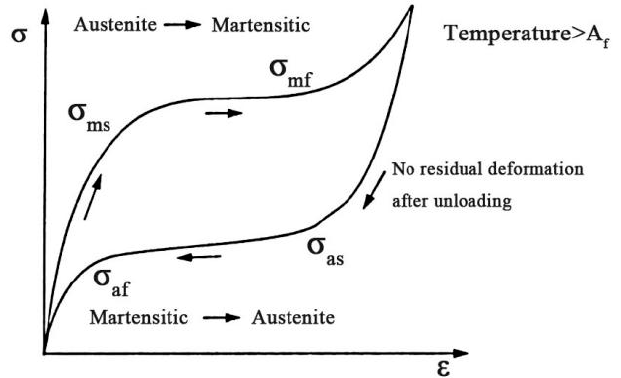
Figure 1. Schematic diagram of SMA superelasticity. Therefore, short and randomly distributed SMA fibers were used instead of the above continuous products in mortar and concrete structures. However, the bonding strength between the SMA fibers and the mortar or concrete matrix is very poor due to the smooth surface of SMA fibers [25]. Therefore, different end shapes for SMA fibers were used to improve the bonding performance. Dehghani et al. [26] found that SMA fibers with 45 ◦ hook end showed a high bond strength with the concrete matrix, while Choi et al. [27,28] found that spearhead end provided a much greater pullout resistance for SMA fibers and showed a good flag-shaped energy dissipation behavior. They [29,30] also indicated that the larger diameter of SMA fibers, the better self-centering capacity of the cementitious composites. Ho et al. [31] found that the crimped fiber with a larger diameter provided a great peak pullout stress. However, due to the brittleness of concrete or mortar, they are easily damaged in tension, so the performance of SMA cannot be fully